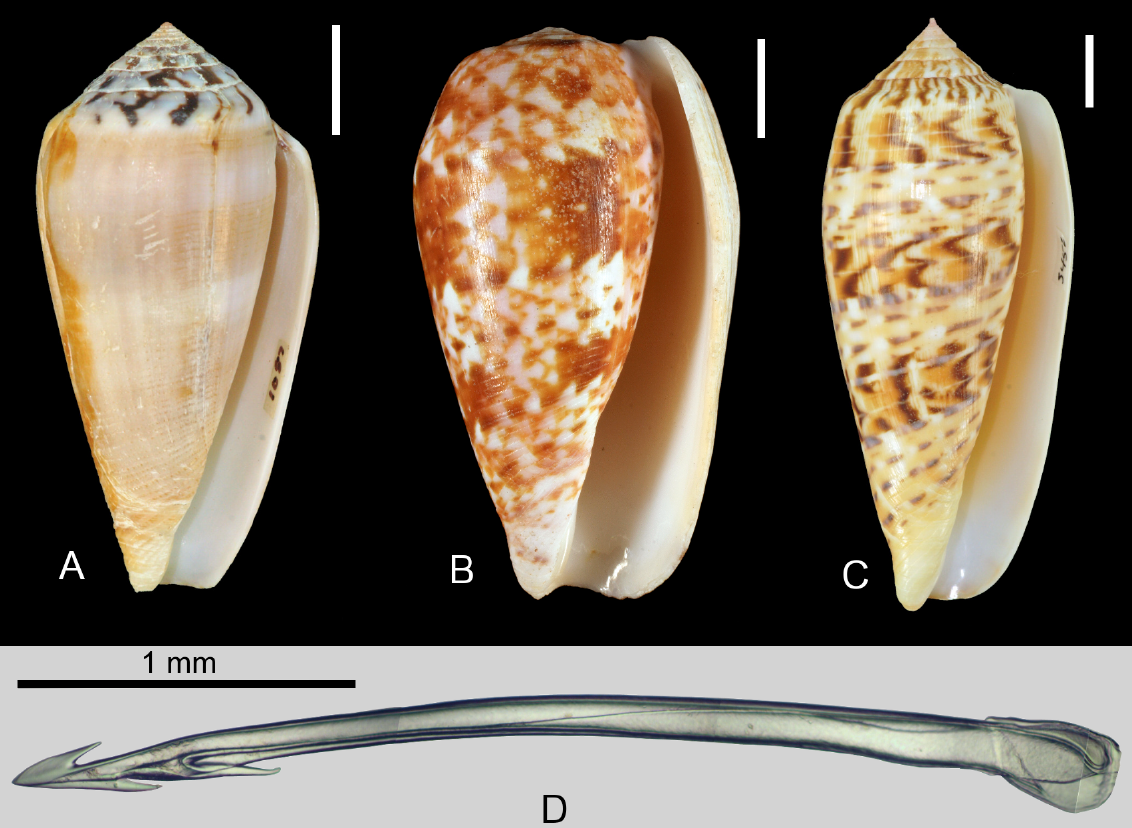
Fig. 2. A . Pionoconus fulmen (Reeve, 1843), specimen from Kii Peninsula, Wakayama prefecture, Japan, 51.9 mm (INHS 44603). B . Textilia bullatus (Linnaeus, 1758), specimen from ua Huka, Baie Kuiapaku, Marquesas Archipelago, 58.1 mm (MNHN IM-2012-20656). C–D . Textilia dusaveli (H. Adams, 1872). C . Specimen from off Balut Island, Mindanao, Philippines, 260 m, 82.1 mm (INHS 44868). D . radular tooth, specimen from New Caledonia, S 67.0 mm (MJT). Scale bars = 10 mm, unless otherwise L